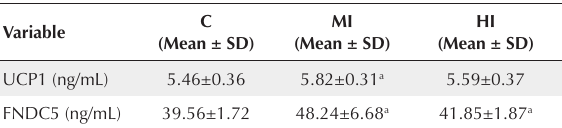
Table 3. The variation of UCP1 and FNDC5 proteins in experimental and control groups after eight weeks of aerobic exercise Variable